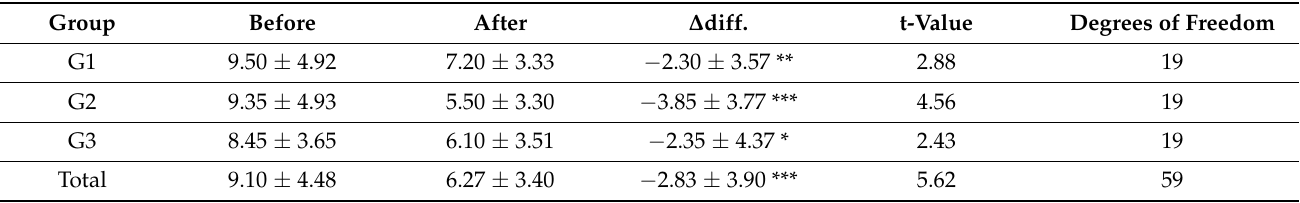
Table 11. The degree of change in the right calcaneal valgus angle in each participant group.